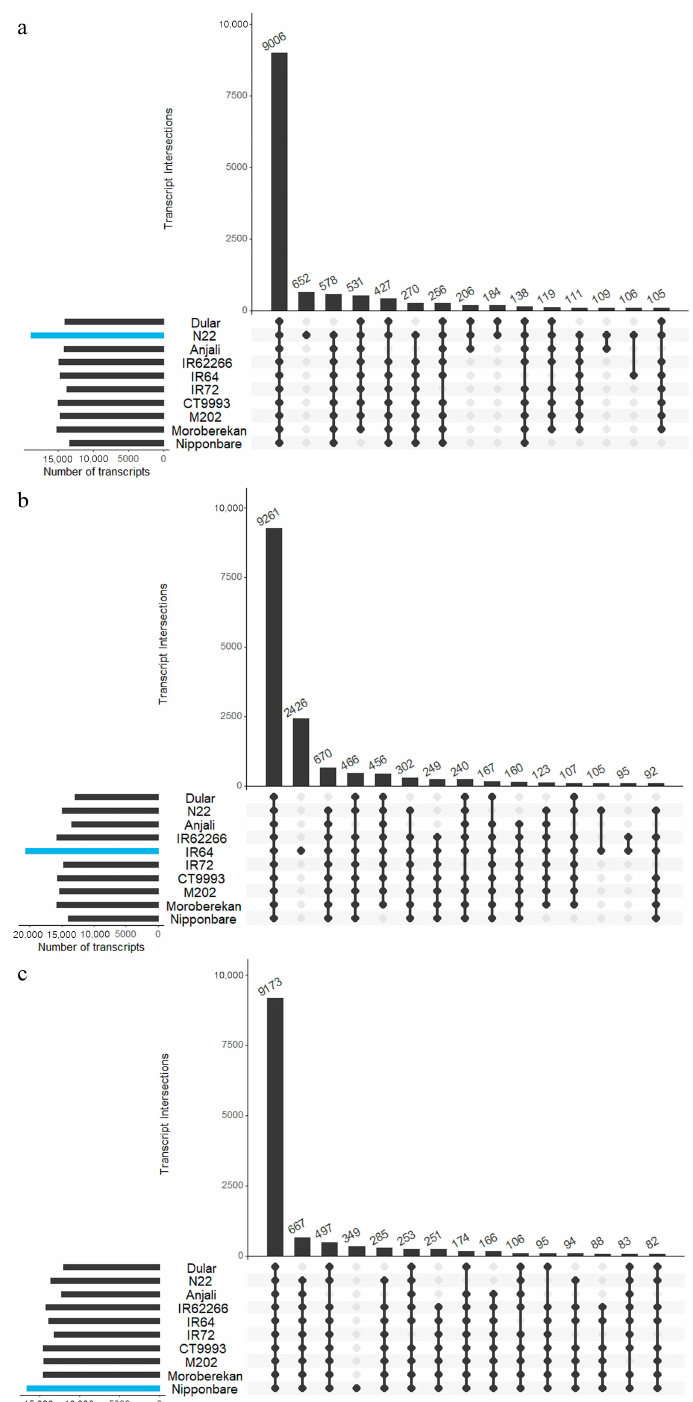
2 Figure 6. Identified common and specific transcripts over all cultivars. Sequence similarities were identified by a blastn search using the transcriptome of a representative cultivar of each subspecies as database. The best hit for each database entry was selected based on the cultivars N22 ( a ), IR64 ( b ), and Nipponbare ( c ). The 15 largest categories were visualized in an UpSet plot. The barplots on the left of the cultivar names represent the size of the datasets, with the blue bars indicating the size of the search space. Dots and vertical lines indicate the cultivars included in the overlap. Barplots in the top panels represent the number of transcripts in the respective comparison. Cultivars were sorted alphabetically within the subspecies aus , indica and japonica